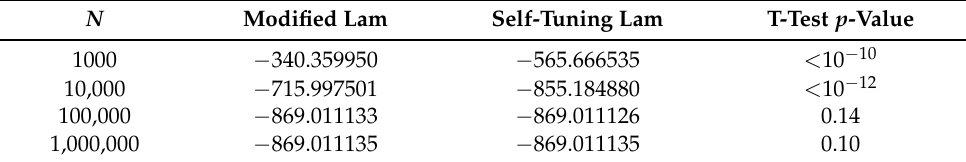
Table 18. Average solution for minimizing g 1000 ( x ) . The minimum is g 1000 ( x ) ≈ − 869.011.